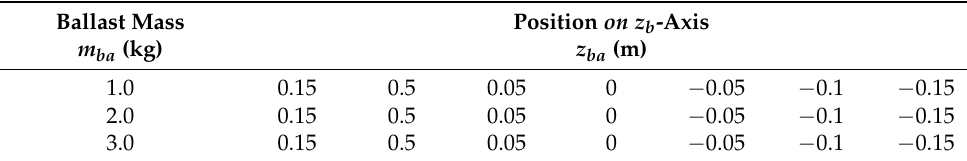
Figure 17. The regulation range of θ for different z ba with m ba equal to 3.0 kg: ( a ) θ vs. λ 1 / − λ 2 ( x r = − 0.478 m); ( b ) θ vs. x r ( λ 1 / − λ 2 = 0°); ( c ) θ vs. λ 1 / − λ 2 ( x r = − 0.358 m). Table 5. The mass and position of ballast for regulating z g .